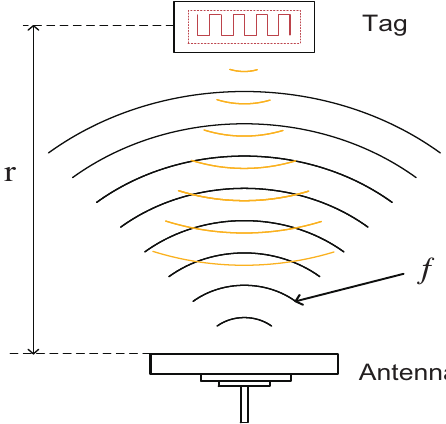
Figure 2. Radio frequency identification (RFID) signal propagation